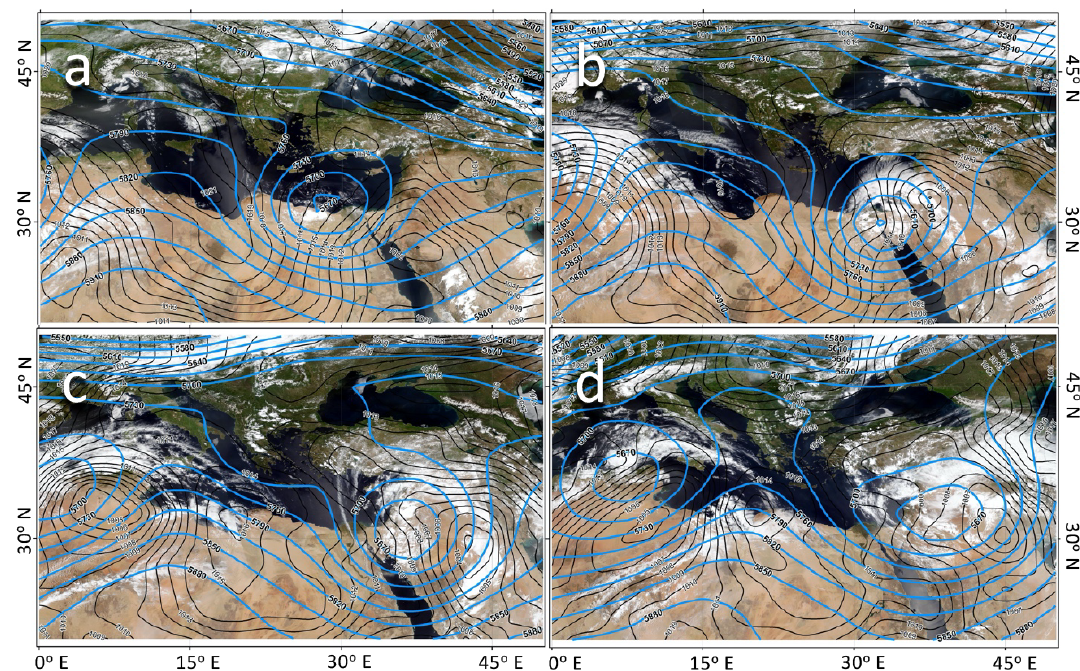
Figure 2. Geopotential height (GPH) (blue lines) at 500hPa (m) and SLP (hPa) (black lines) projected on MODIS imagery, in 24h intervals, for 24–27 April 2018 at 12:00UTC ( a–d ).